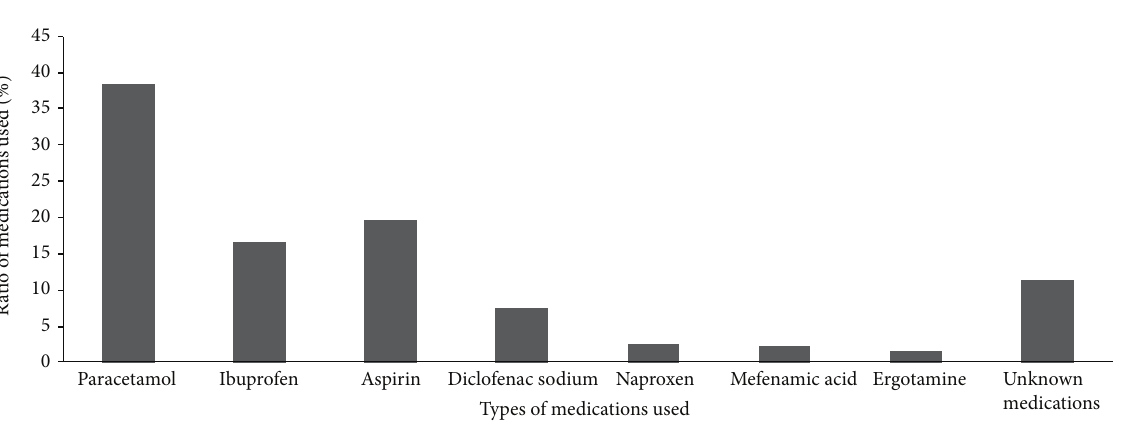
Figure 1: Medications use among headache patients ( 𝑛 = 10996 ). Note: some patients use different medications at an increase of headache frequency.